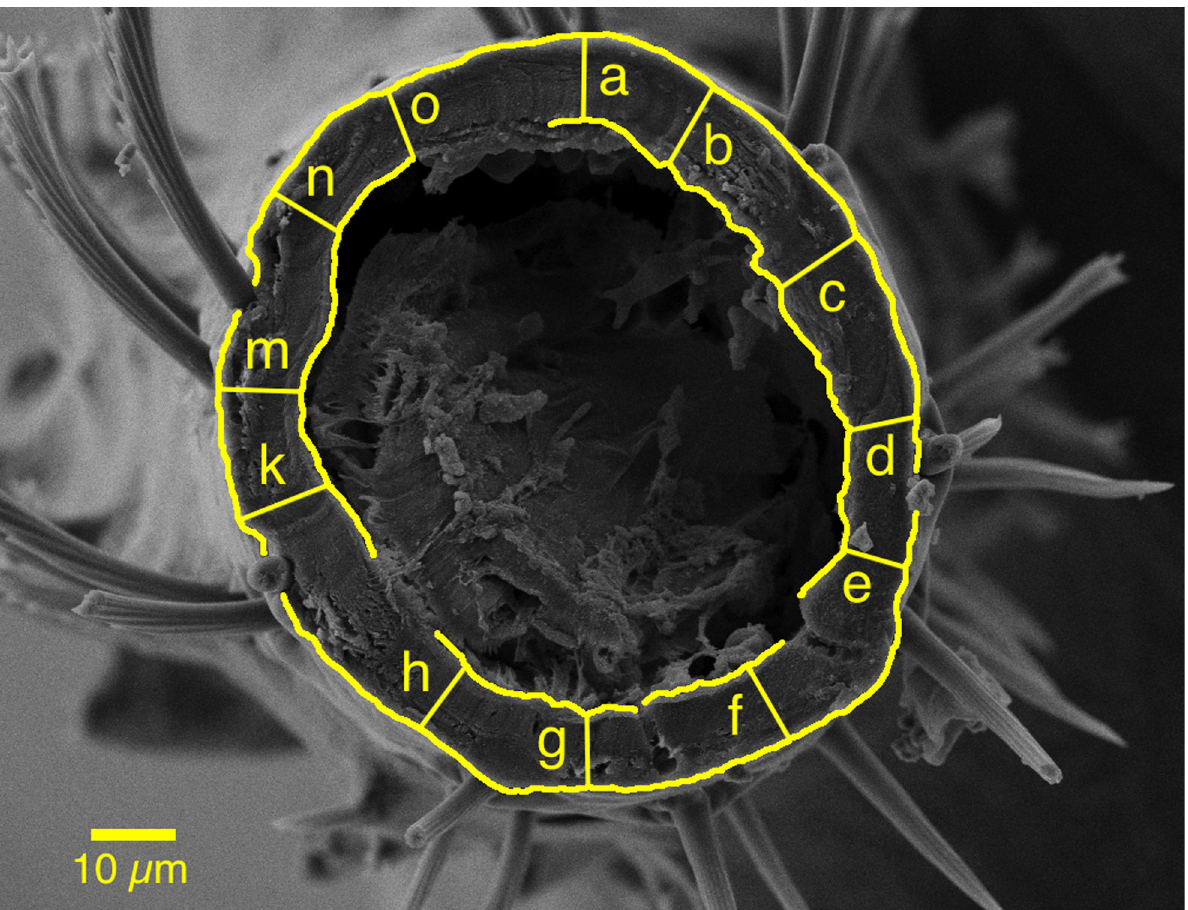
Fig 1. Transverse section of Cimex lectularius (Parramatta strain) middle leg tibia and example of twelve point-to-point cuticle measurements methodology. Letters denote measurements of: a = 9.15 μ m, b = 9.82 μ m, c = 10.25 μ m, d = 7.91 μ m, e = 7.16 μ m, f = 8.42 μ m, g = 8.02 μ m, h = 8.41 μ m, k = 10.12 μ m, m = 8.82 μ m, n = 8.31 μ m, o = 8.09 μ m [i, j and l not included for purpose of legibility].